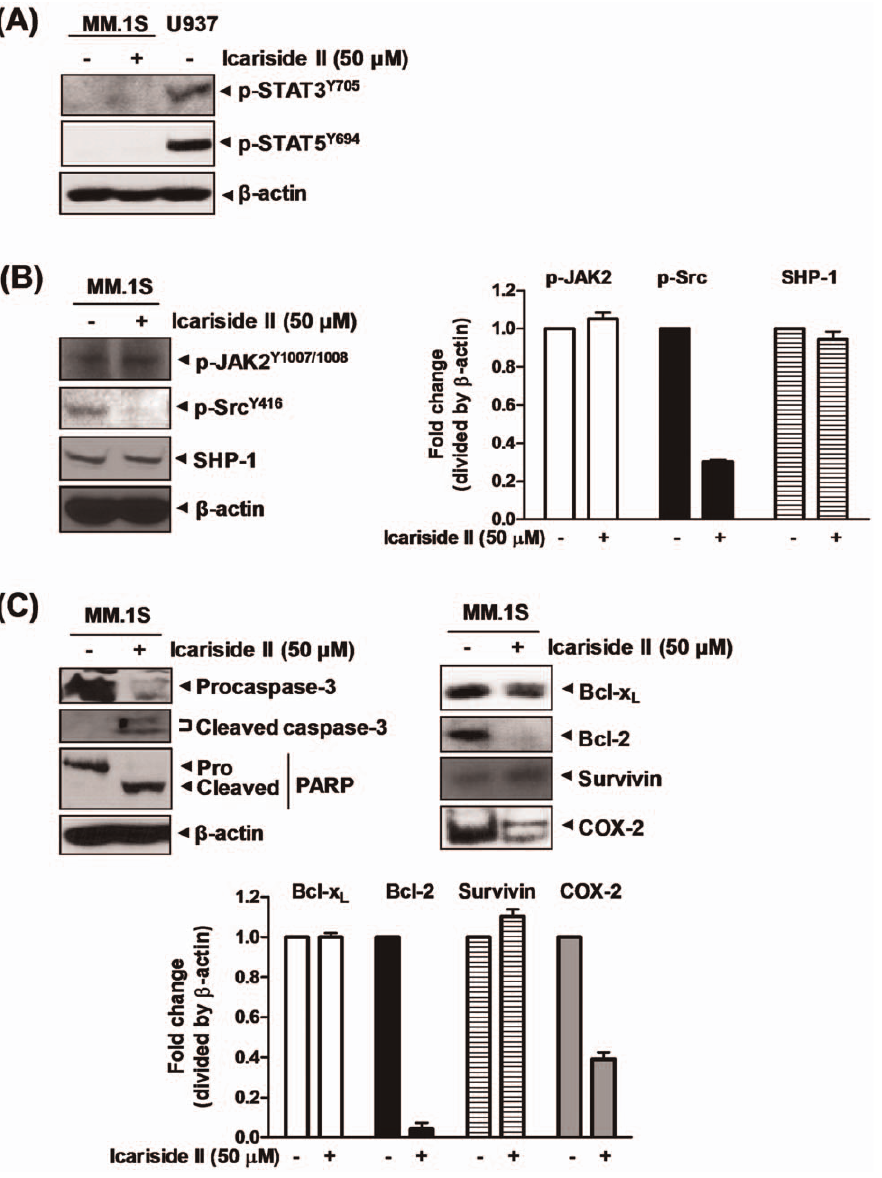
Figure 7. Effects of Icariside II on STAT3-related signaling in STAT3 inactive MM.1S cells. (A) MM.1S cells were treated with or without 50 m M Icariside II for 9 h. Cell lysates were prepared and subjected to Western blotting for phospho-STAT3 and phospho-STAT5. U937 cells were used as a control of phospho-STAT3 and 5. (B) MM.1S cells were treated with or without 50 m M Icariside II for 9 h. Cell lysates were prepared and subjected to Western blotting for phospho-JAK2, phospho-Src and SHP-1. (C) MM.1S cells were treated with or without 50 m M Icariside II for 24 h. Cell lysates were prepared and subjected to Western blotting for procaspase-3, PARP, bcl-x L , bcl-2, survivin and COX-2. Representative results of three independent experiments are shown for each experiment.